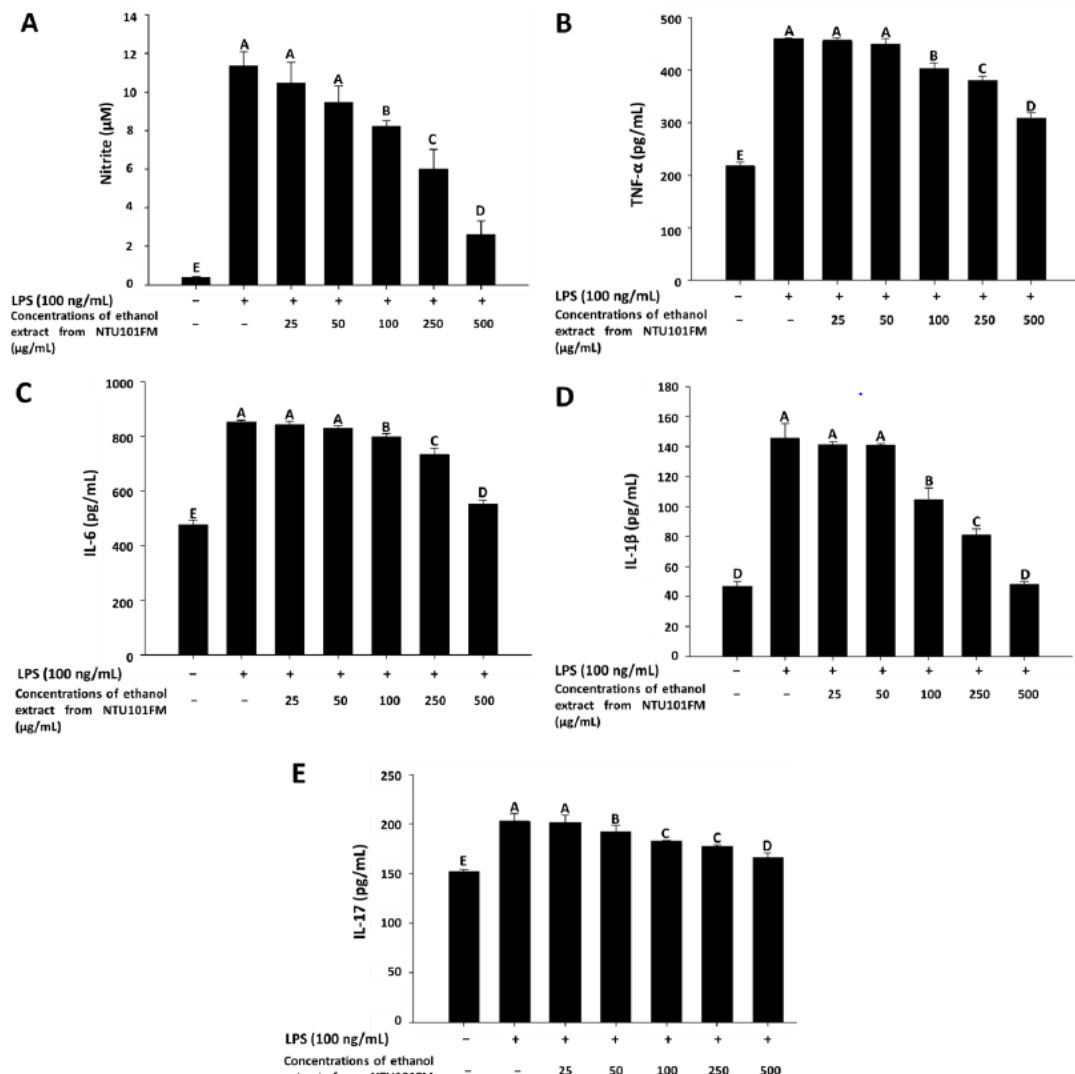
Figure 2. Effects of NTU101FM ethanol extract on: ( A ) NO; ( B ) TNF- α ; ( C ) IL-6; ( D ) IL-1 β ; and ( E ) IL-17 of LPS-induced inflammation RAW 264.7 cell. Cells were treated with various concentrations of NTU101FM ethanol extract (25 to 500 µ g/mL) for 24 h. The data are presented as means ± SD ( n = 3). Values with different uppercase letters were significant by Duncan’s multiple range tests ( p < 0.05). NTU101FM, NTU 101-fermented skim milk; NO, nitric oxide; TNF- α , tumor necrosis factor- α ; IL-6, interleukin-6; IL-1 β , interleukin-1 β ; IL-17, interleukin-17; LPS,